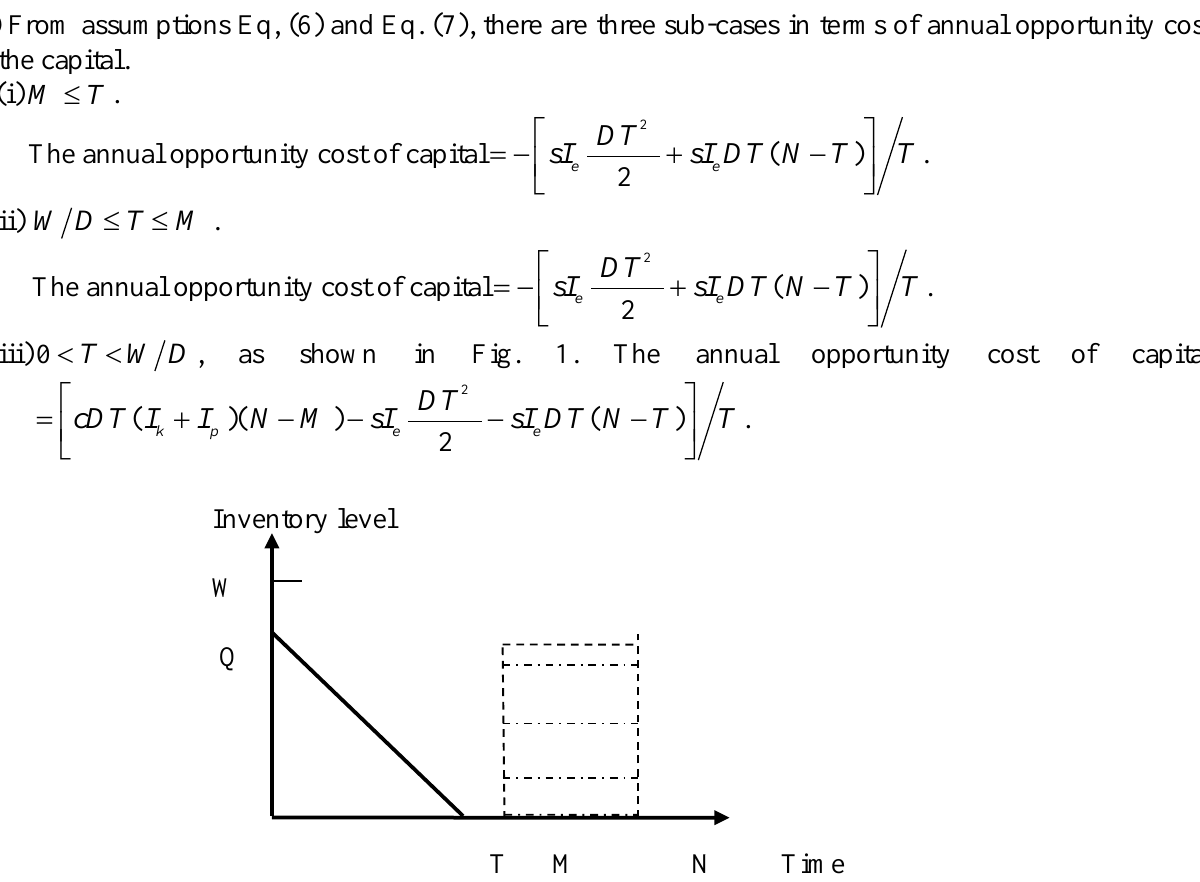
Fig. 1. The inventory level and the total saved amount of interest payable